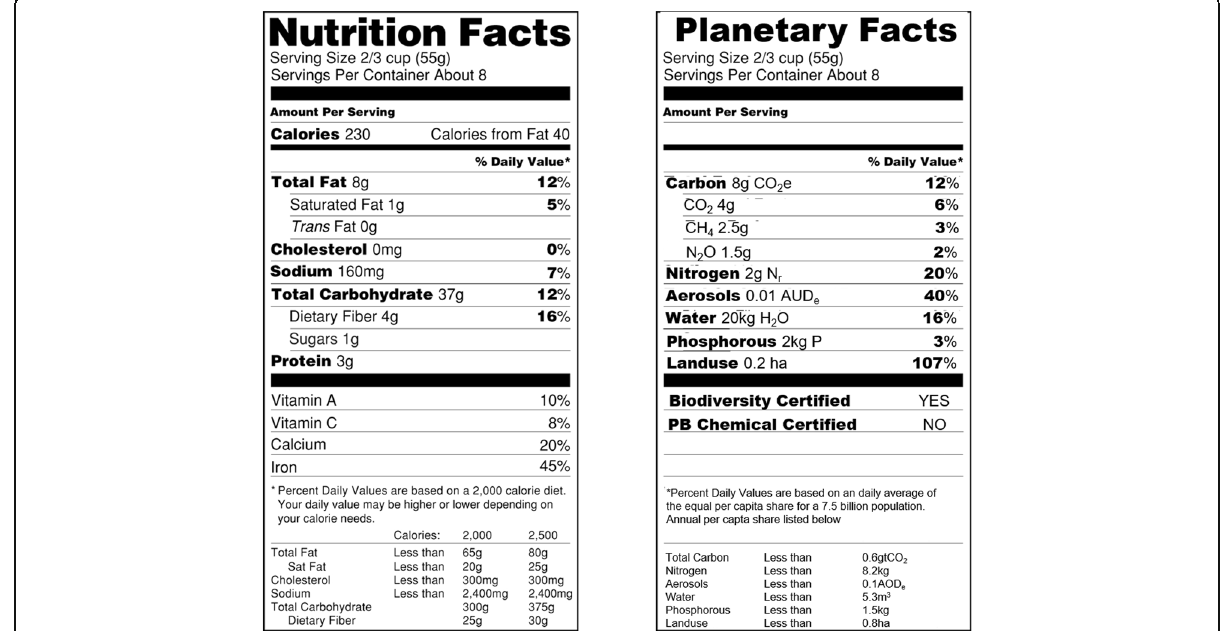
Fig. 8 Planetary Facts